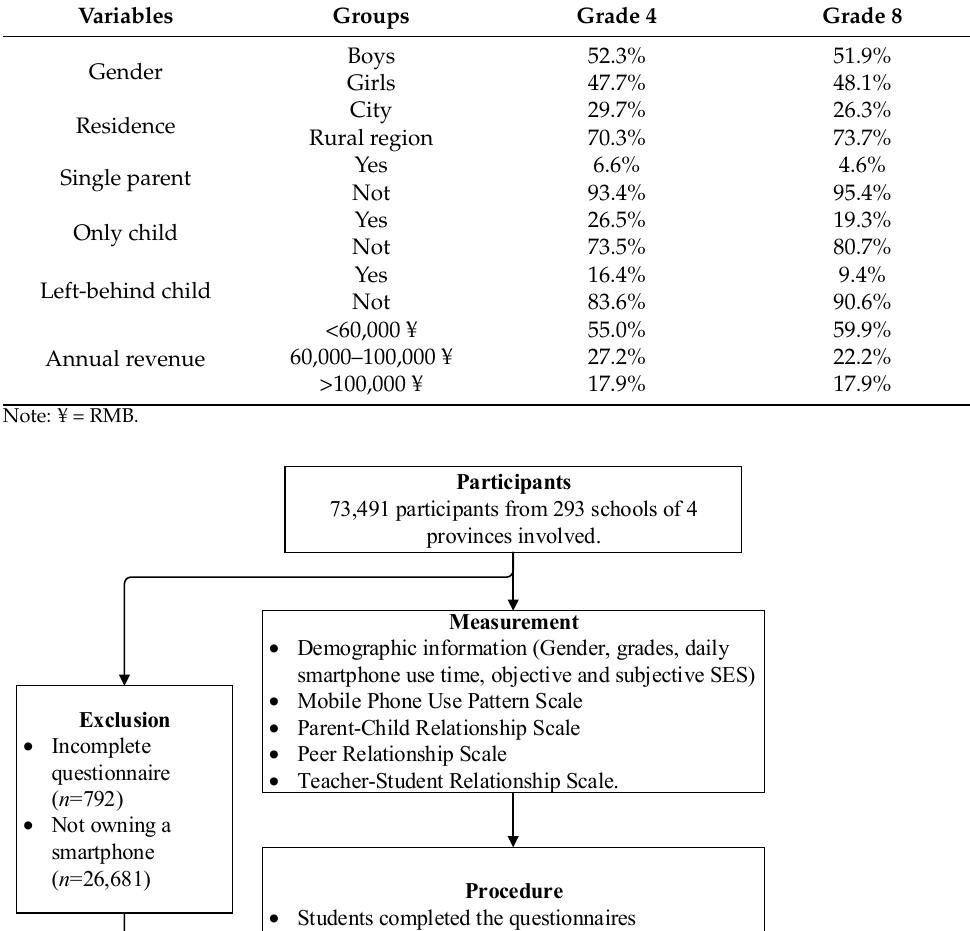
Table 1. Participants characteristic of grade 4 and grade 8 students.